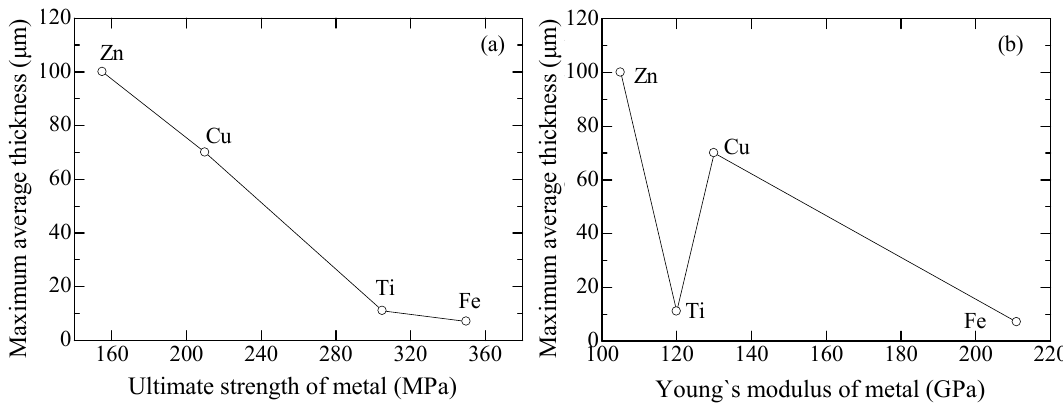
Figure 14. Relationship between maximum average thicknesses of continuous metal coatings.